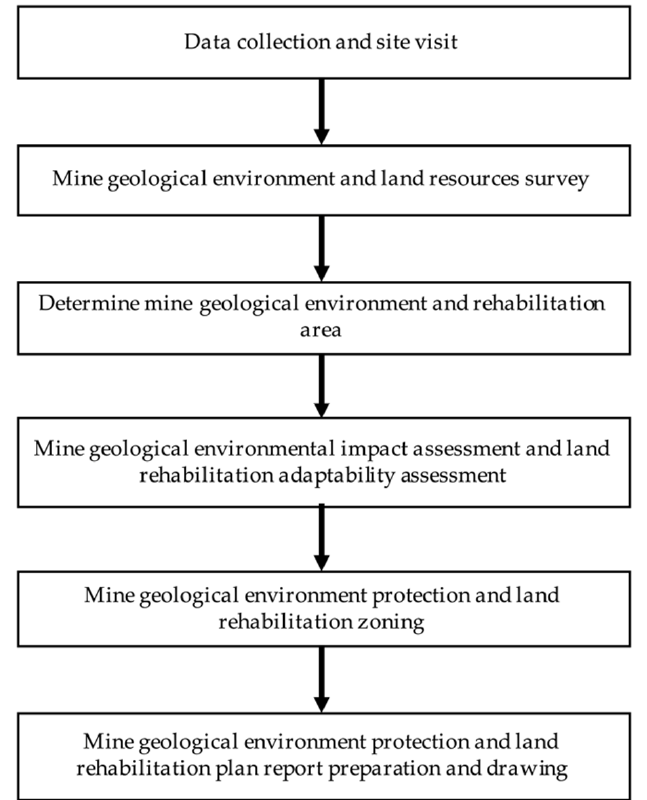
Figure 6. Program diagram of mine geological environment protection and land rehabilitation scheme. Source: Guidelines for Preparation of Mine Geological Environment Protection and Land Rehabilitation Plan, Ministry of Land and Resources of the People’s Republic of China, December 2016.